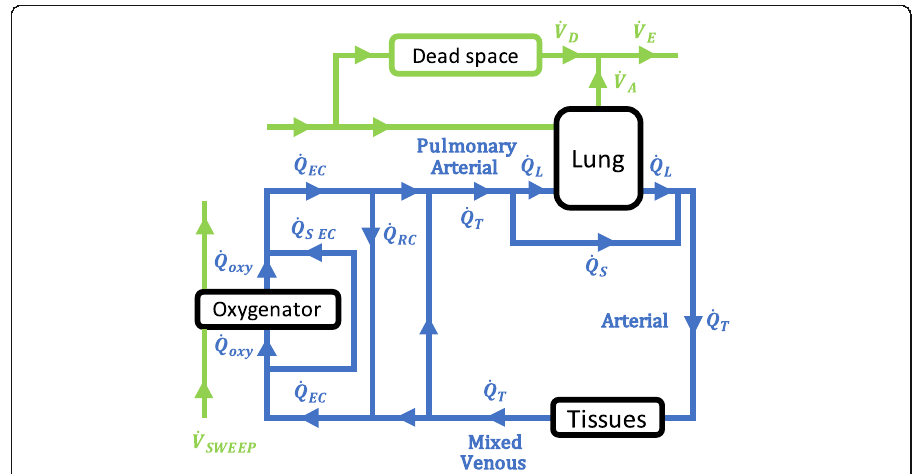
_ Q S EC is shunt